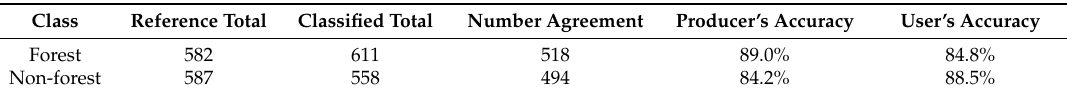
Table 6. Average forest map accuracy. Validation of the 2000–2014 annual NDVI forest change dataset was derived from all points from 2000 to 2014 visually interpreted using Landsat and high-resolution imagery. Areas are classified as forest or non-forest for each year of study. Overall accuracy using this approach was